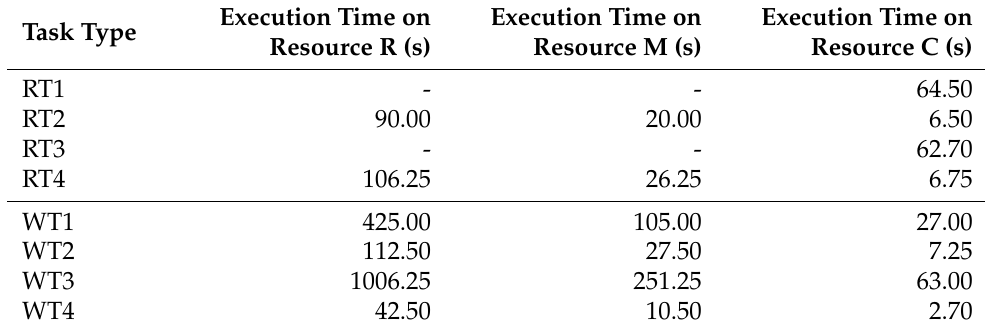
Table 4. Expected execution times of read and write tasks on edge and cloud resources. Task Type